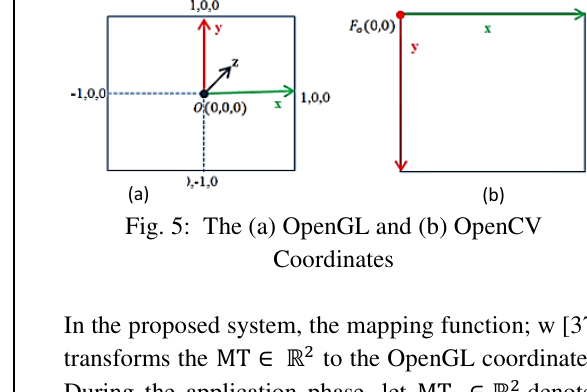
Fig. 5: The (a) OpenGL and (b) OpenCV